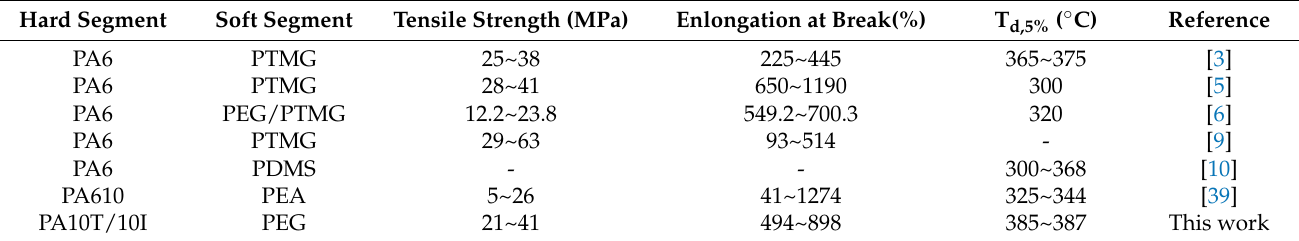
Figure 6. Tensile properties for TPAEs and PA10T/10I. Table 3. A summary of the key published results of TPAE.